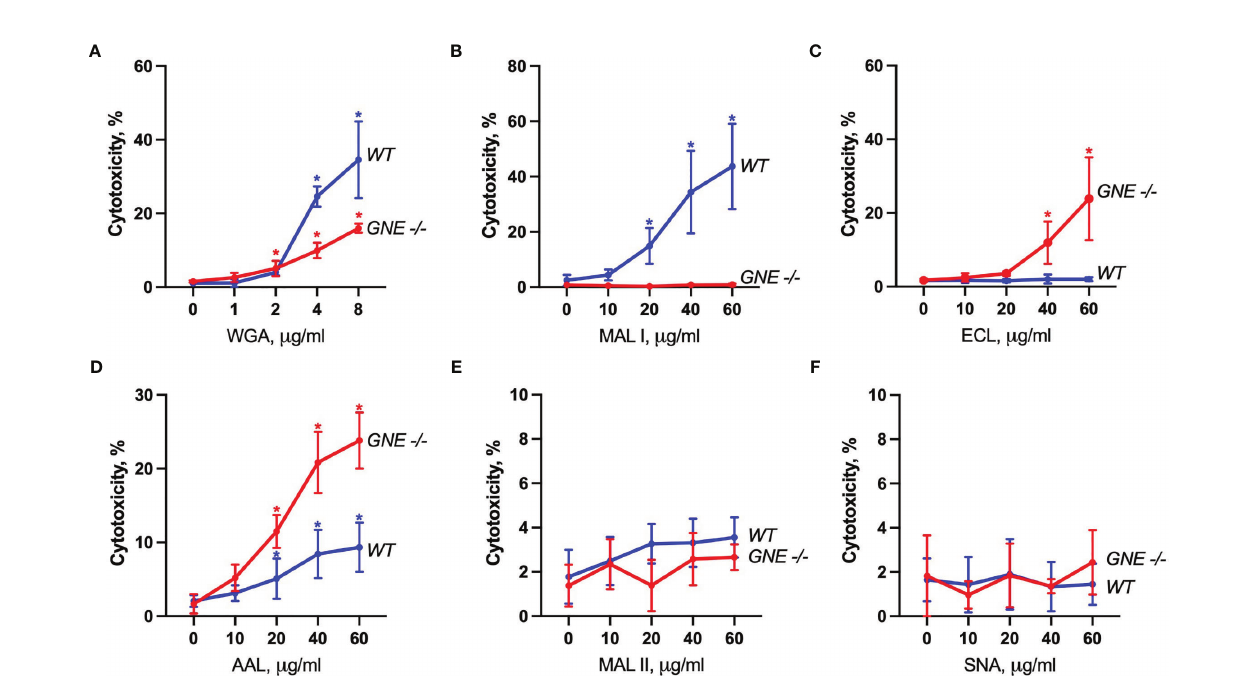
FIGURE 2 | Lectin-induced cell death in MC-38 cells. Cytotoxicity was measured by propidium iodide and Hoechst 33342 staining of cells after treatment with WGA (A) , MAL I (B) , ECL (C) , AAL (D) , MAL II (E) , and SNA (F) lectins in WT and GNE de fi cient cells for 20 h. Data represent averages and SD of 6 replicates out of 2 independent experiments. *p < 0.05; one-way ANOVA followed by Bonferroni ’ s multiple comparison